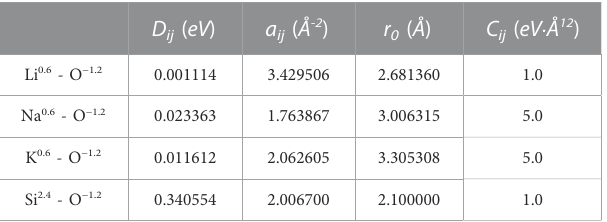
TABLE 2 Densities ( ρ in g · cm − 3 ) used to calculate the volume of the simulation cell (Bansal and Doremus, 2013). x ρ (g · cm -3 ) Na 0.1 FIGURE 2 Schematic representation of preparation steps for measurement at different temperatures. Different temperatures were used to produce a reliable glass structure starting from a random distribution oftheatoms.Beyondtheverticalline,anelectric fi eldof0.05 V/Å was applied to the x -axis.